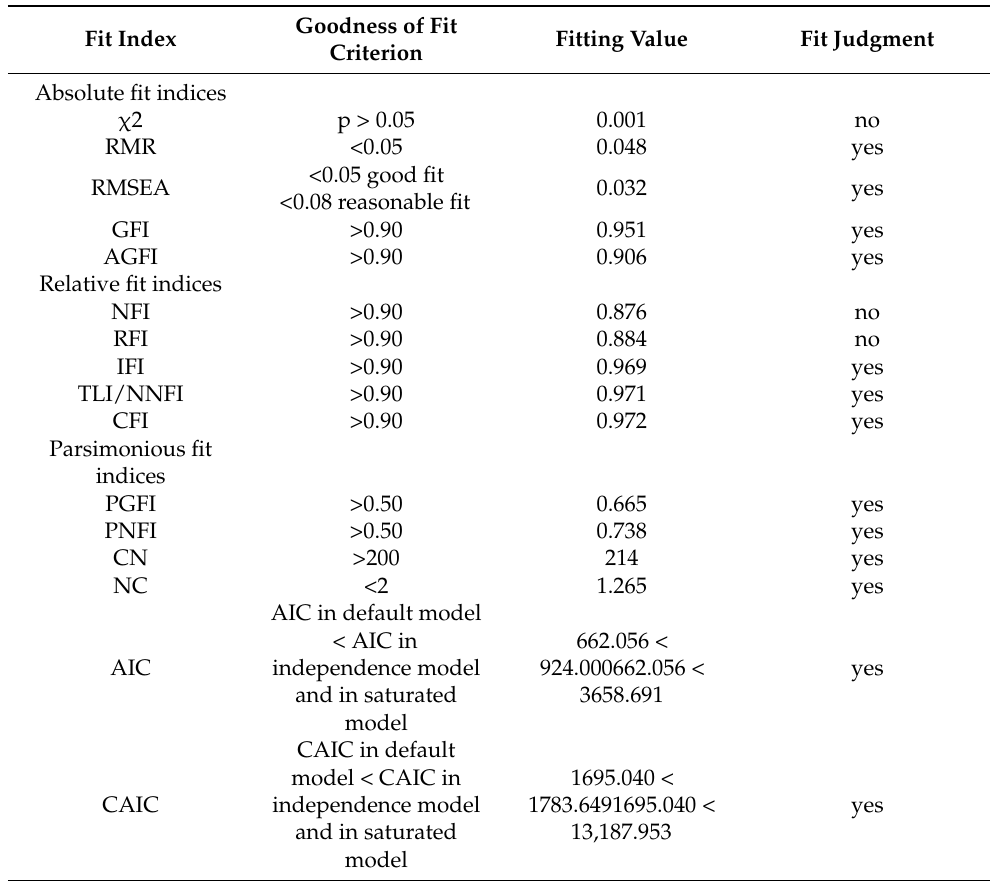
Table 5. Fitness test indicators.